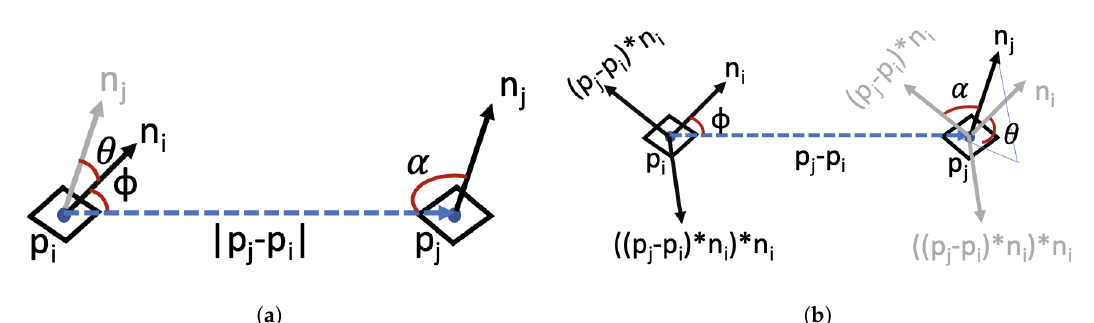
Figure 4. Representation of 4d feature set for Point Pair Features (PPF) and PFH approaches. The features are the distance between two selected surface points ( p i and p j ), and α , Φ and θ angles ( a ) PPF setting, ( b ) PFH